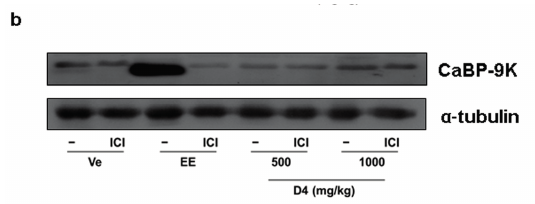
Figure 5. CaBP-9K expression at the mRNA ( a ); and protein ( b ) levels in immature female SD rats. Data presented in the graph are divided according to chemical administered and subdivided according to the presence or absence of ICI 182 780 (shown as ICI). a p < 0.05 vs. vehicle, b p < 0.05 vs. without ICI. Data are presented as the mean ± SD.